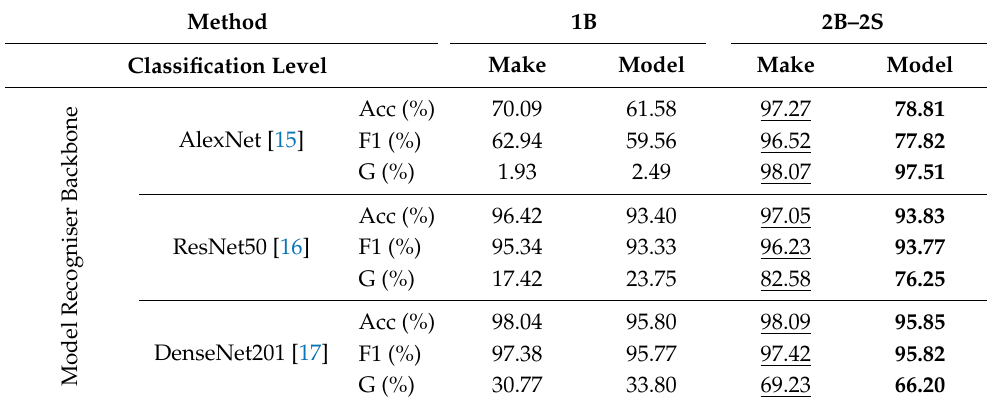
Table 7. VMMR results over VMMRDB-51 [4].